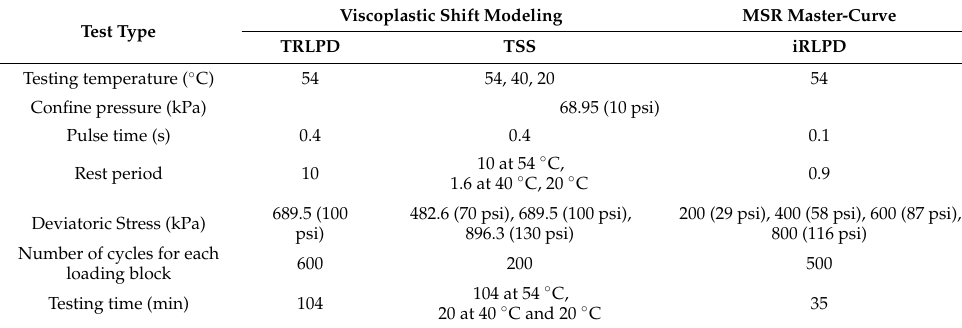
Table 2. TRLPD, TSS, and iRLPD test